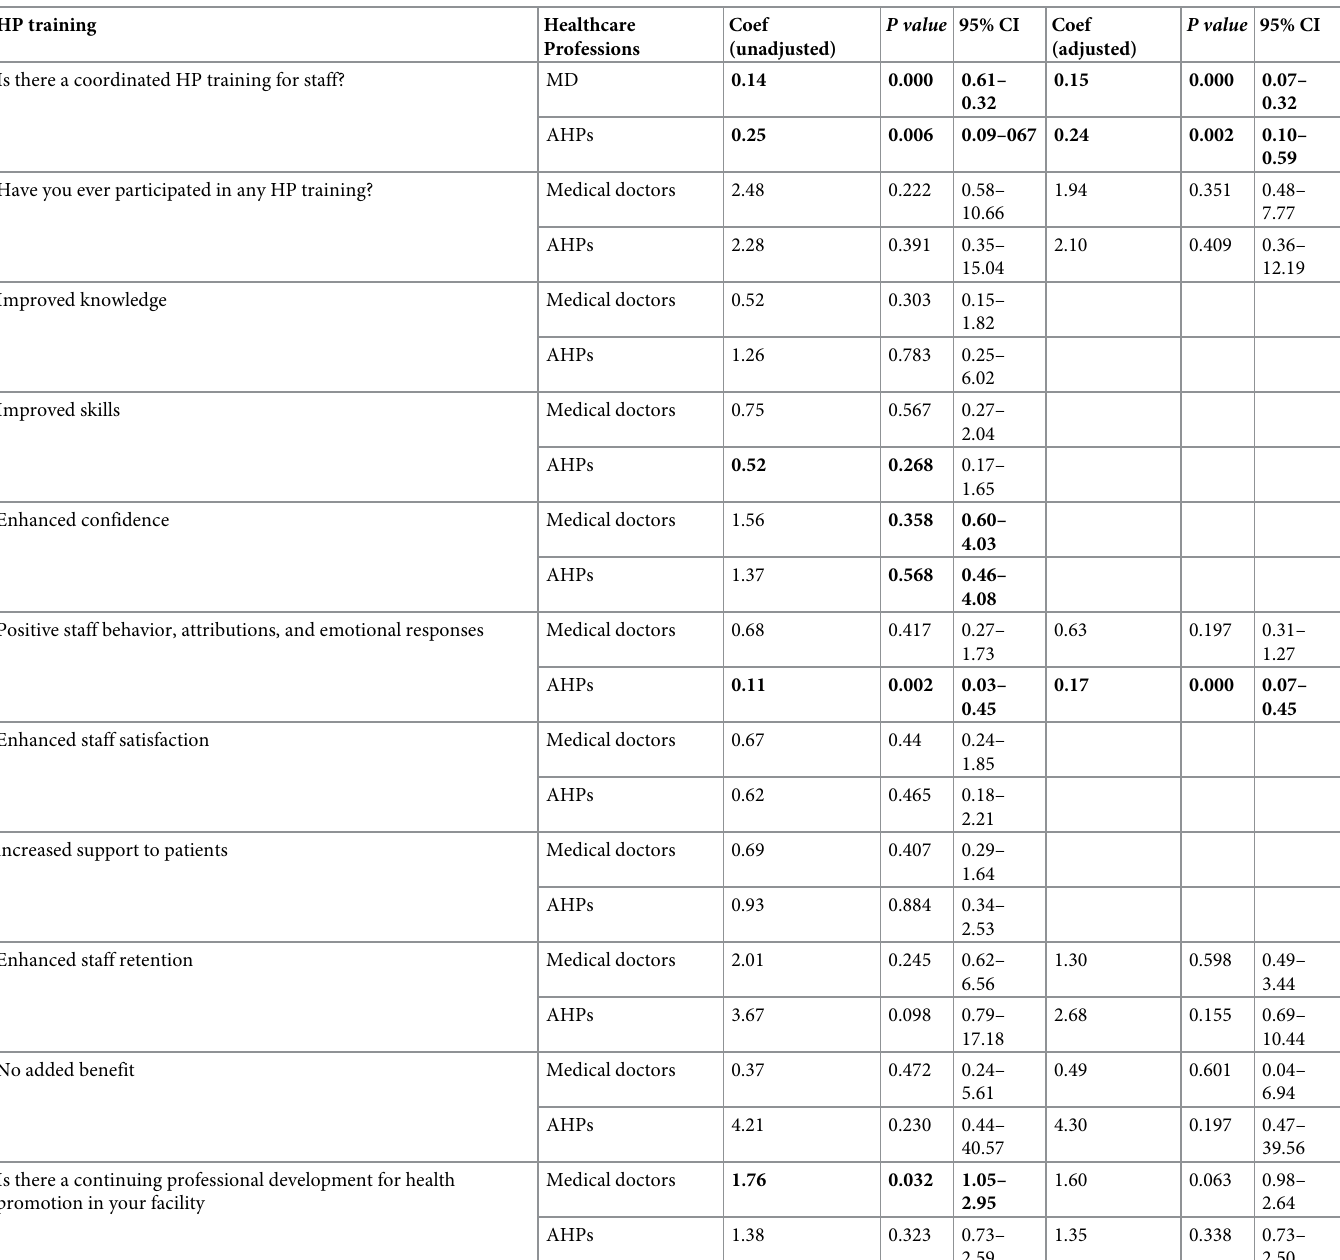
Table 3. Multivariate analysis between HCP and HP